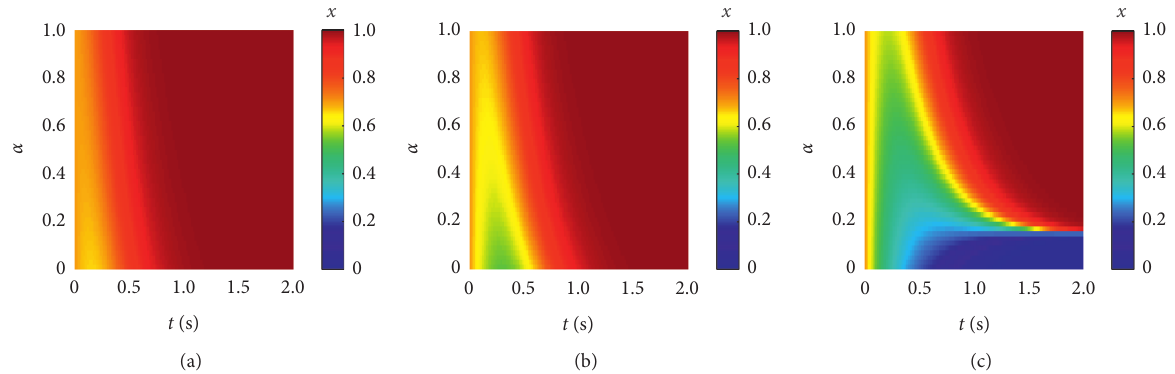
Figure 6: Evolutionary convergence of the proportion of lane changing strategy under different penetration rates of the connected autonomous bus. (a) M